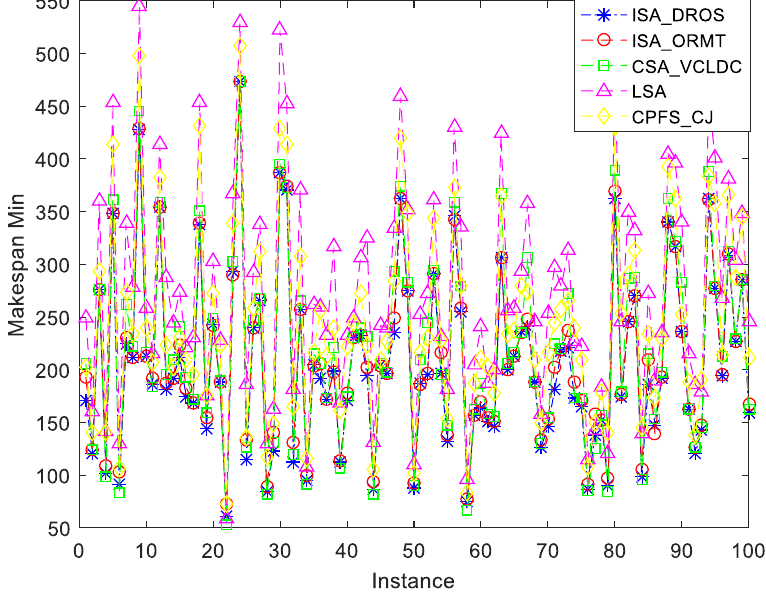
Figure 12. The minimum time required by each of the five algorithms to process products.